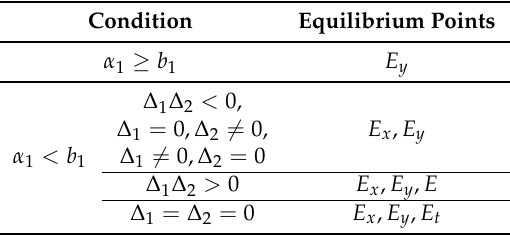
Table 3. The equilibrium points for system